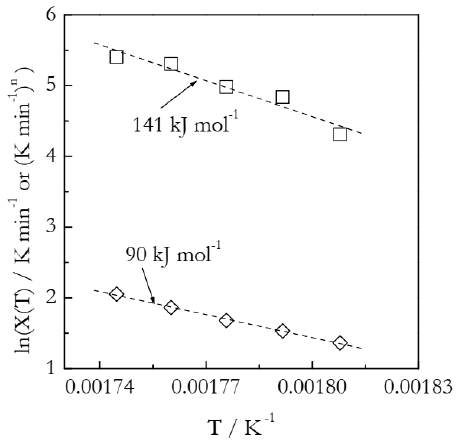
10 of 13 Figure 8. Ozawa plots for cyanate ester polymerization. Numbers by the symbols are temperatures in K. Dash lines are least square fits to respective points. Table 3. The Ozawa–Avrami model parameters for the cyanate ester data. T/K